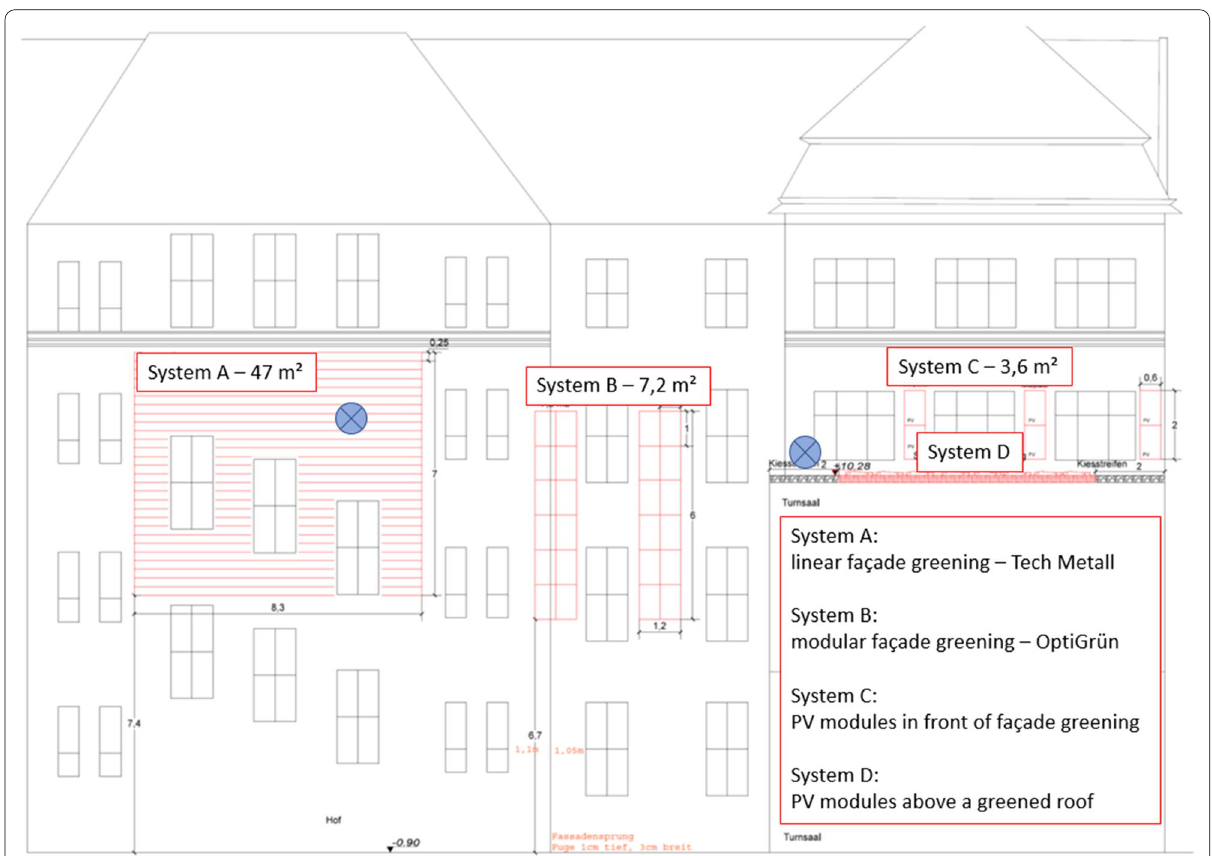
Fig. 9 Greening systems (red lines) and measurement positions (blue dots) within the inner courtyard at the school GRG 7 Kandlgasse in